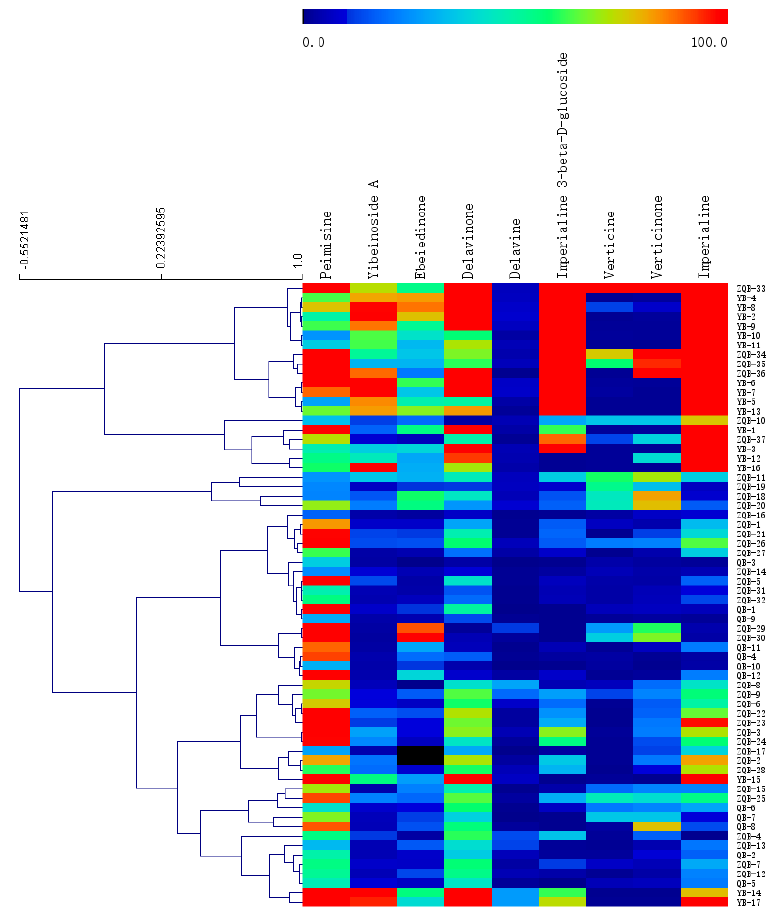
Figure 3. The HCA of FCB and FPB based on the content of nine steroidal alkaloids .